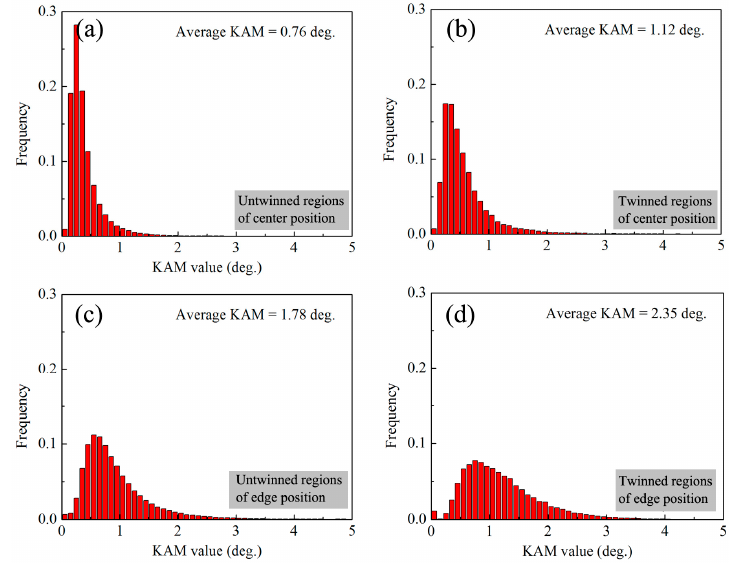
Figure 8. KAM value distribution of ST sample: ( a ) un-twinned regions of center position; ( b ) twinned regions of center position; ( c ) un-twinned regions of edge position and ( d ) twinned regions of edge position.